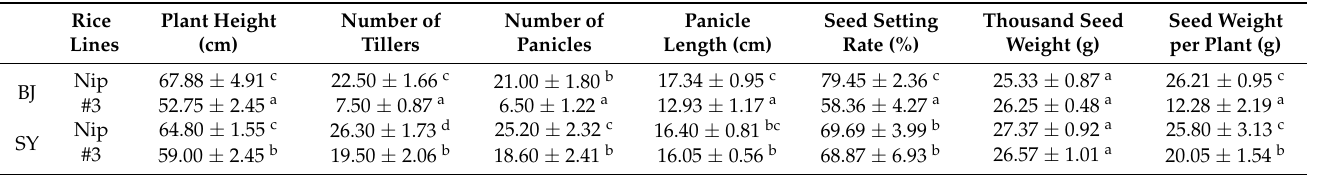
Table 1. Agronomic characteristics of Nipponbare and Xa23p1.0 transgenic rice in Beijing and Sanya field